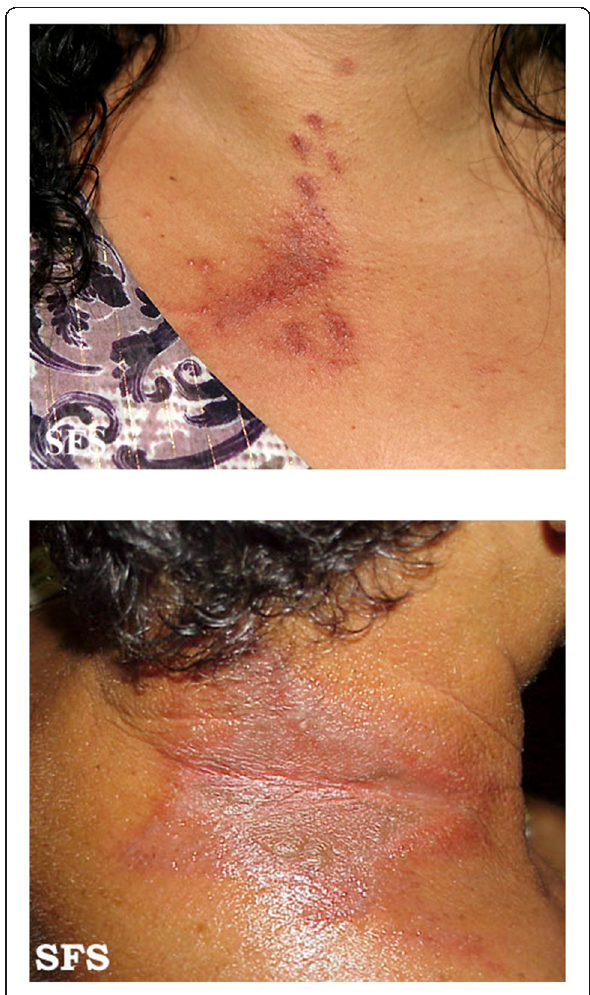
Figure 3 General symptoms of Paederus dermatitis (images by Samuel Freire da Silva, M.D. in homage to the master and professor Delso Bringel Calheiros, available at http://www.atlasdermatologico.com.br/index.jsf).